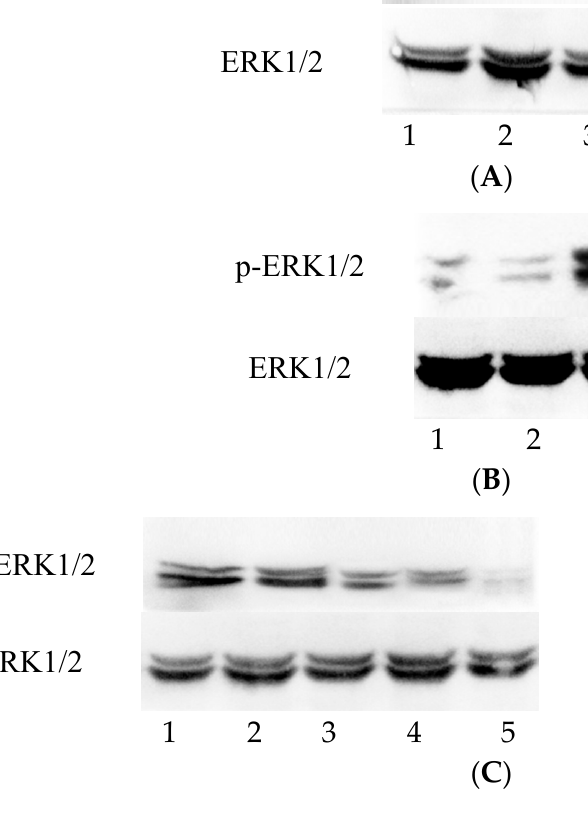
Figure 1. The amount of protein loaded in each lane is 100 μ g. ERK1/2 was set as a loading control at the same time. ERK1/2, extracellular signal-regulated kinase 1 and 2; p-ERK1/2, phosphorylated ERK1/2. ( A ) The Western blotting of p-ERK1/2 and ERK1/2 for Group C (the Chlamydia trachomatis group) at different time points. Lanes 1 to Lane 5 represent the time points of 0, 12 h, 24 h, 36 h, and 48 h, respectively; ( B ) The Western blotting of p-ERK1/2 and ERK1/2 for four groups after 48 h of incubation. 1: Group C + A, the azithromycin-treated group. 2: Group C + V, the Vp1-treated group. 3: Group C, the Chlamydia trachomatis group. 4: Group M, the blank group (only McCoy cells); ( C ) The Western blotting of p-ERK1/2 and ERK1/2 for Group C + V and Group C + A during the incubation at different time points. Lanes 1 to Lane 5 represent the time points of 0, 12 h, 24 h, 36 h, and 48 h for Group C + V, respectively. Lanes a–e represent the time points of 0, 12 h, 24 h, 36 h, and 48 h for Group C + A, respectively.